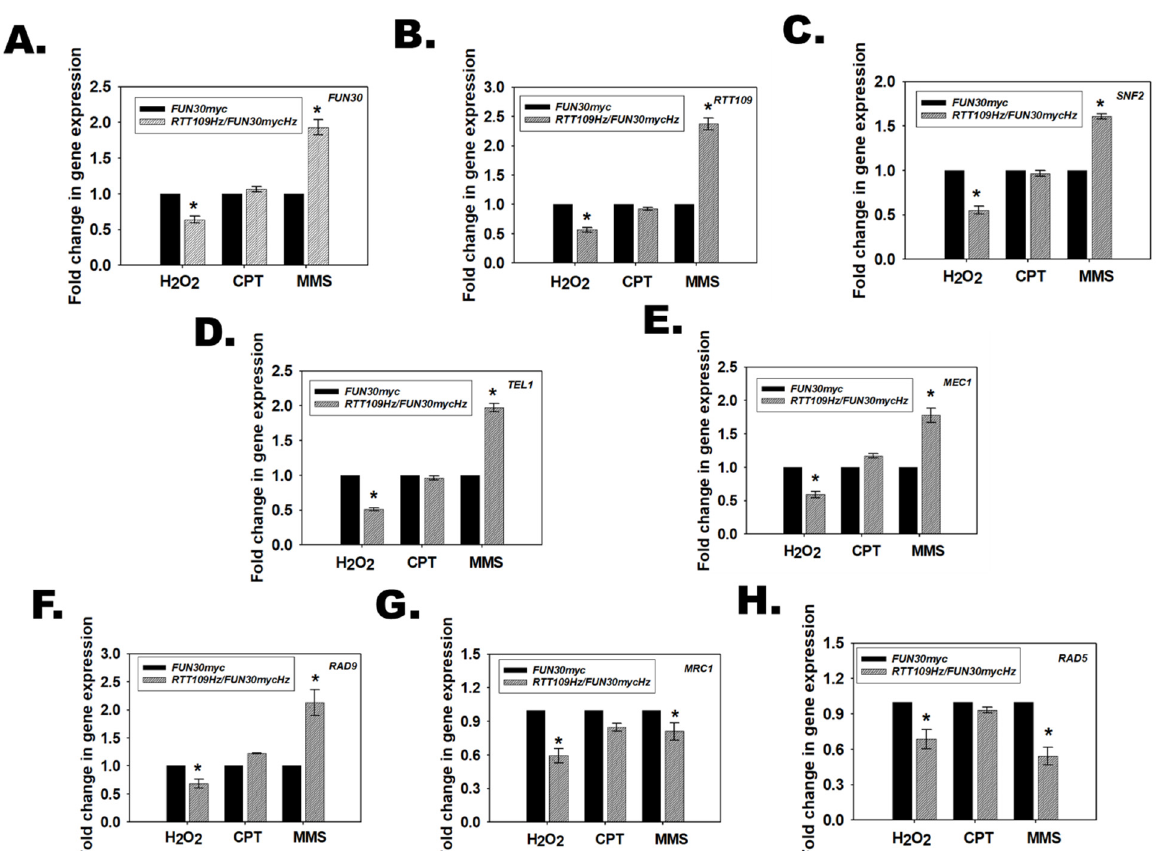
Figure 6. Rtt109 and Fun30 in RTT109Hz/FUN30Hz regulate the transcription of DNA damage response pathways genes differentially in response to different types of genotoxic stressors. Expression of ( A ). FUN30 ; ( B ). RTT109 ; ( C ). SNF2 ; ( D ). TEL1 ; ( E ). MEC1 ; ( F ). RAD9 ; ( G ). MRC1 ; ( H ). RAD5 was analyzed in FUN30myc and RTT109Hz/FUN30mycHz strains in the presence of H 2 O 2 (7.5 mM), CPT (100 µM), and MMS (0.02%). The qPCR data are presented as average ± s.e.m. of three biological replicates. * p < 0.05.